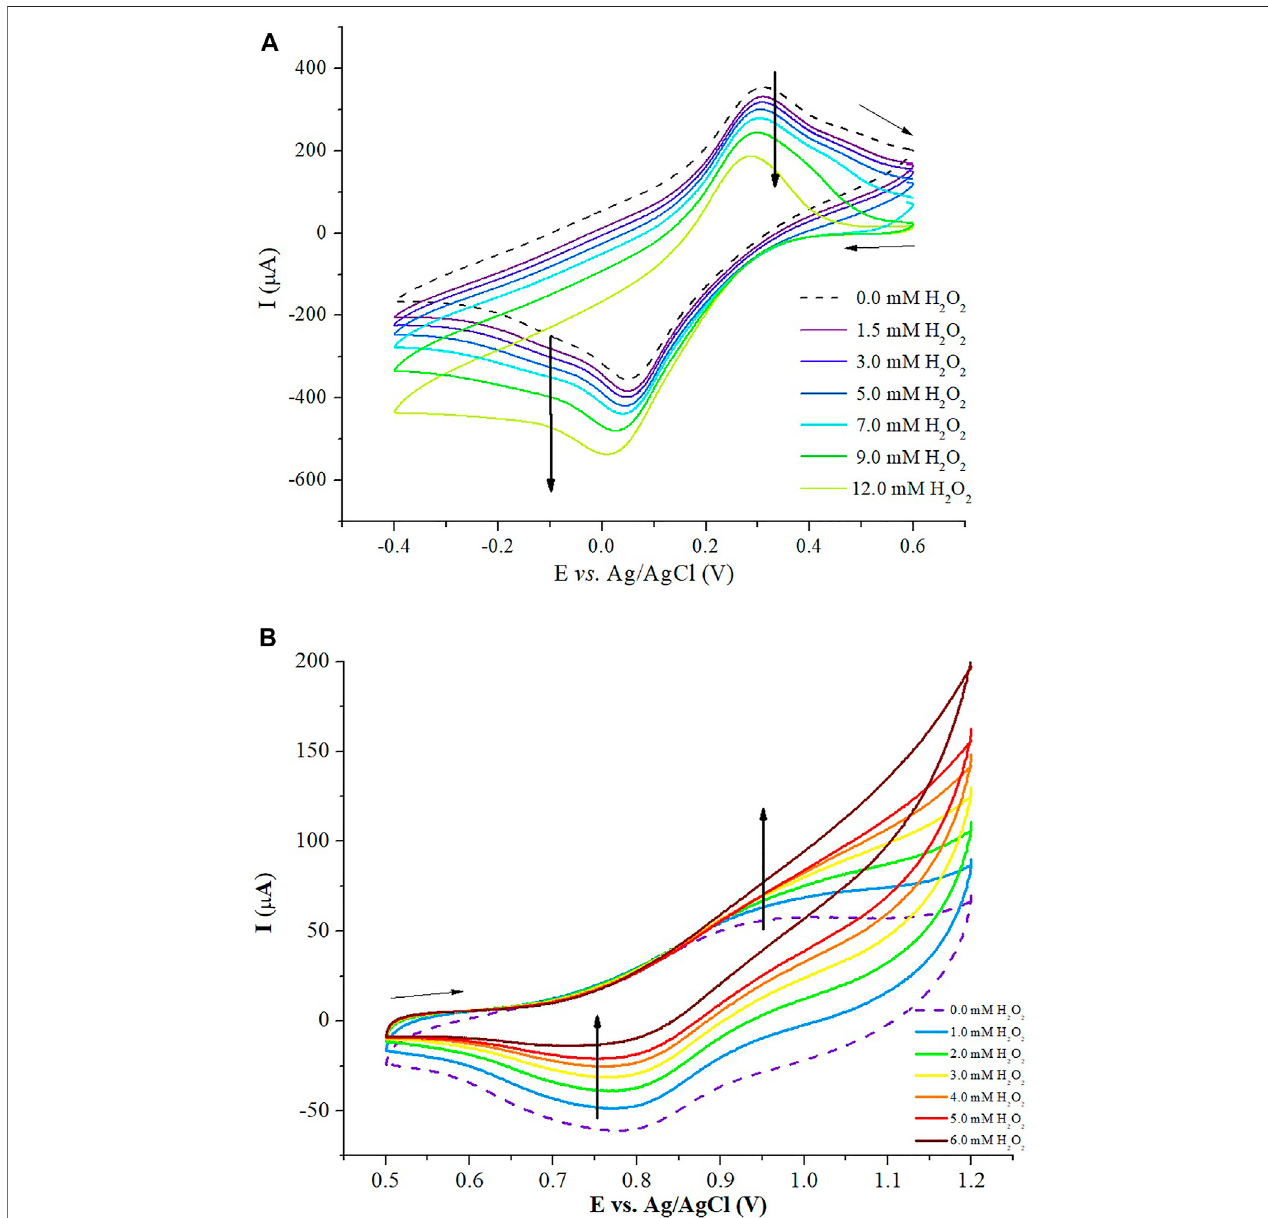
FIGURE11|(A) CyclicvoltammetryofH 2 O 2 atthePB-fCNT/TiO 2 .ZrO 2 (36)500 ° C.20/GC-modi fi edelectrode(reductionzone)in0.1molL -1 PBS(pH.3.0)at40mV s -1 . (B) Cyclic voltammetry of H 2 O 2 at the PB-fCNT/TiO 2 .ZrO 2 (36)500 ° C.20/GC-modi fi ed electrode (oxidation zone) in 0.1mol L − 1 PBS (pH. 3.0) at 40 mV s -1 .